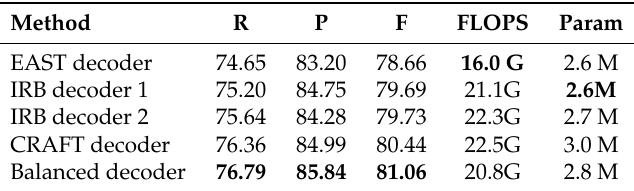
Table 5. Comparison of several decoders with the ICDAR2015 dataset, where R , P , and F represent the recall, precision, and F1 score, respectively. The results are obtained using the same backbone MobileNetV2.